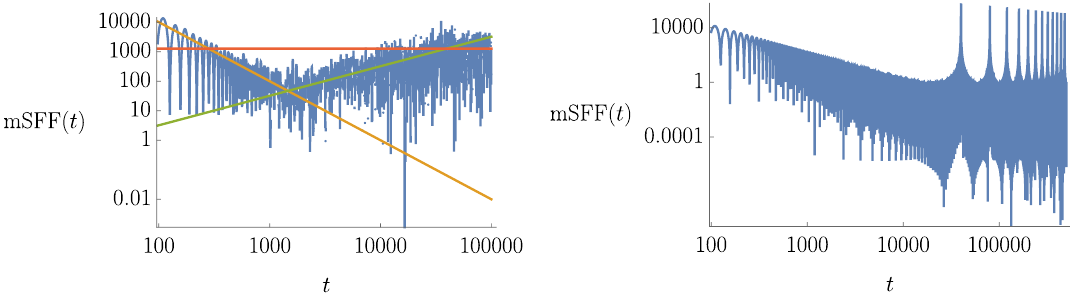
Figure 2 . Left: microcanonical spectral form factor for GUE as a function of time for a bin of size 1 / 10 centered around zero energy. Right: same microcanonical spectral form factor but with a spectrum obtained from the electrostatics problem (5.2) with a Gaussian potential V = 1 / 2 x 2 . We clearly see a huge difference between the plot on the right, not only are there the Poincare recurrences, but there is no ramp region as well. In both plots we used L = 10 4 and the bin contained 1272 eigenvalues. We verified that the recurrence time is indeed 2 πρ (0) = 4 × 10 4 even if appearing non-uniform in the figure above due to the log-log